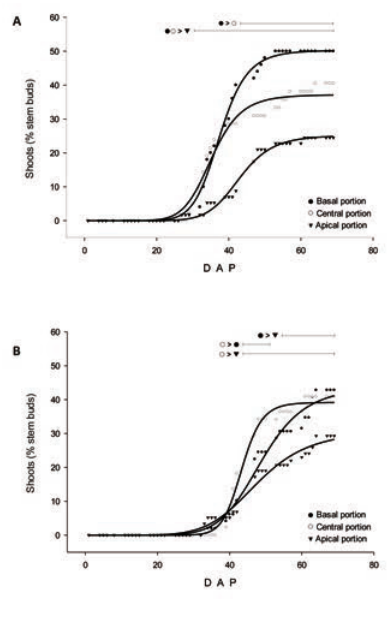
Figure 2. Shoot emergence from different stem portions of plants propagated by micropropagation (A) and by rhizomes (B) in spring period (segments in the upper graph part indicate the differentiation period between